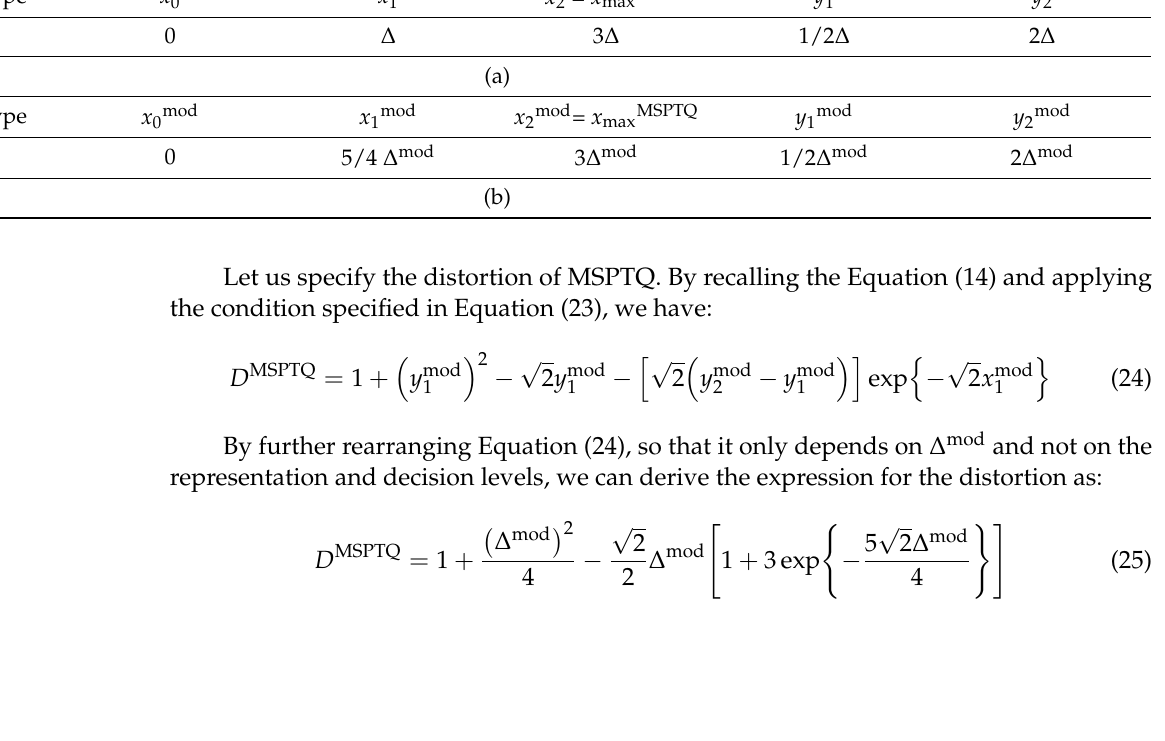
Figure 3. Granular region, (cid:60) g , and overload region, (cid:60) o , of the symmetric two-bit MSPTQ. Table 1. The decision thresholds and representation levels of our two-bit (a) SPTQ and (b) MSPTQ. Quantizer type x